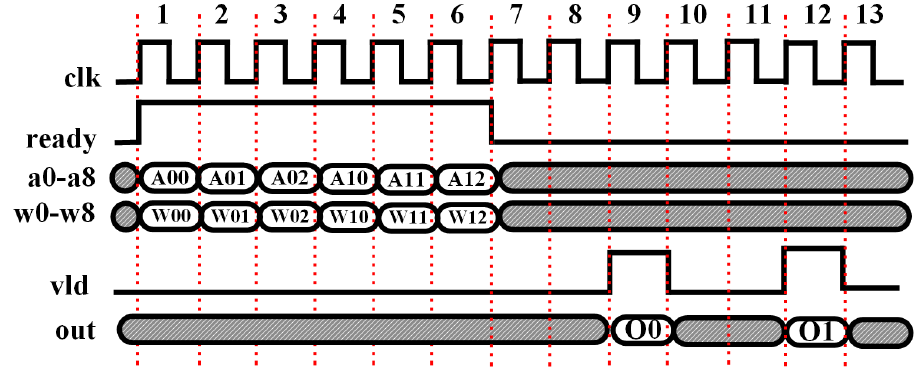
Figure 9. Timing diagram of iterative design of a convolutional layer